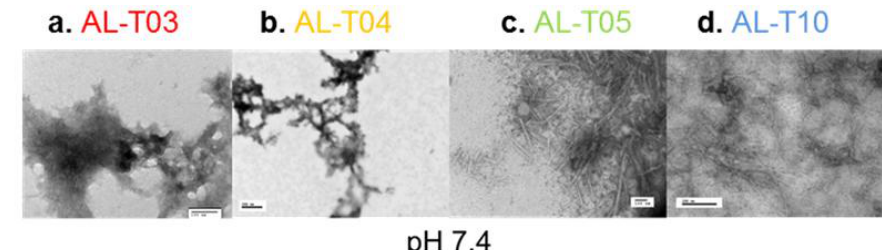
Figure 5. Transmission electron microscopy of representative amyloid fibrils ( a – d ) Amyloid formation reactions at pH 7.4; ( e – h ) Amyloid formation reactions at pH